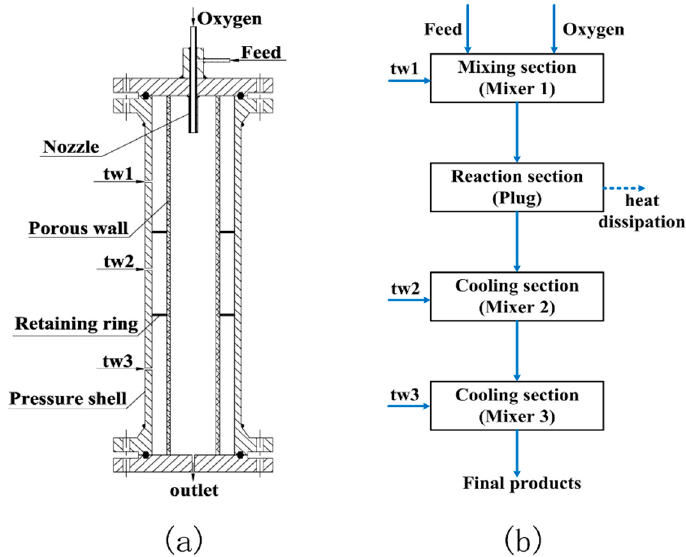
Figure 8. ( a ) The experimental diagram of the TWR and ( b ) the simplified model for the TWR in Aspen plus.